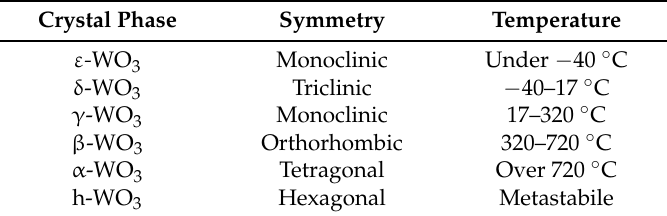
Table 2. WO 3 has several different stable crystal phases [38,48].